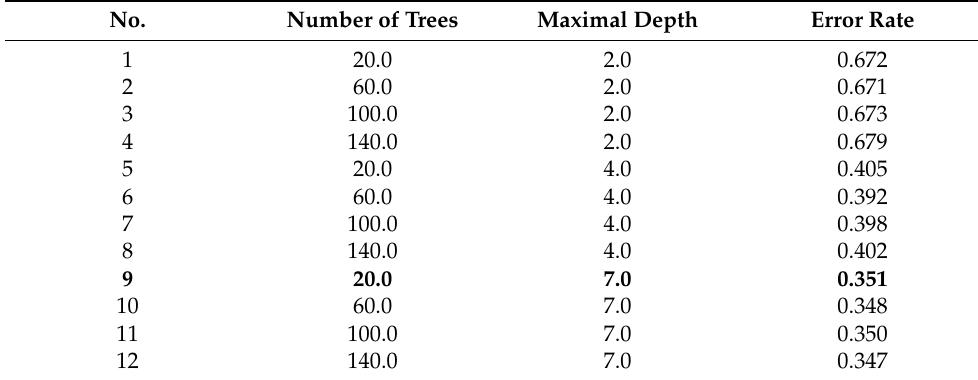
Table 7. The optimization process of RF models with error rate.